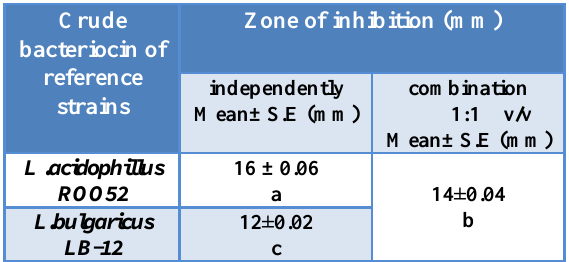
Table, 4: Zone of inhibition of indicator organisms upon the use of bacteriocins of Lactobacillus acidophilus ROO52 and Lactobacillus bulgaricus LB- 12 independently and in combination.